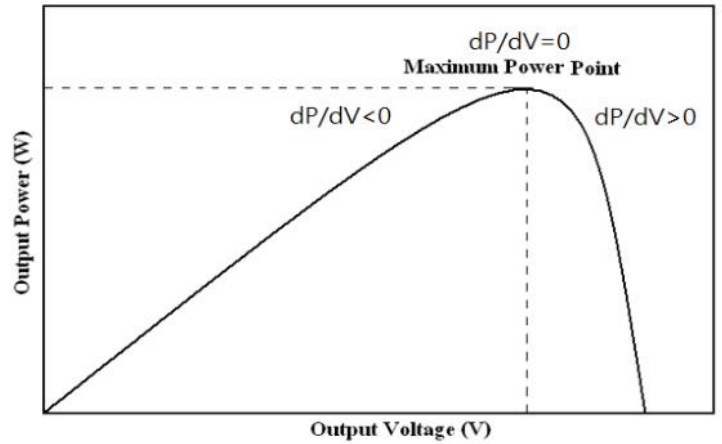
Figure 6. Perturb and observe Method